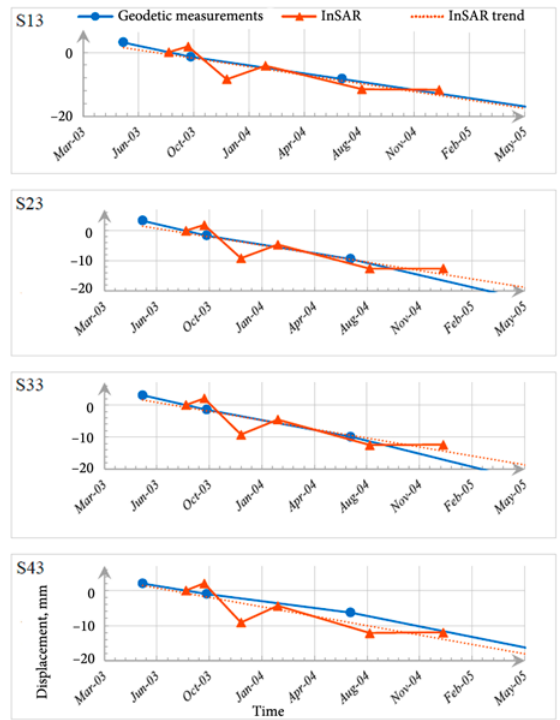
Fig. 7. Comparison of InSAR results and geodetic